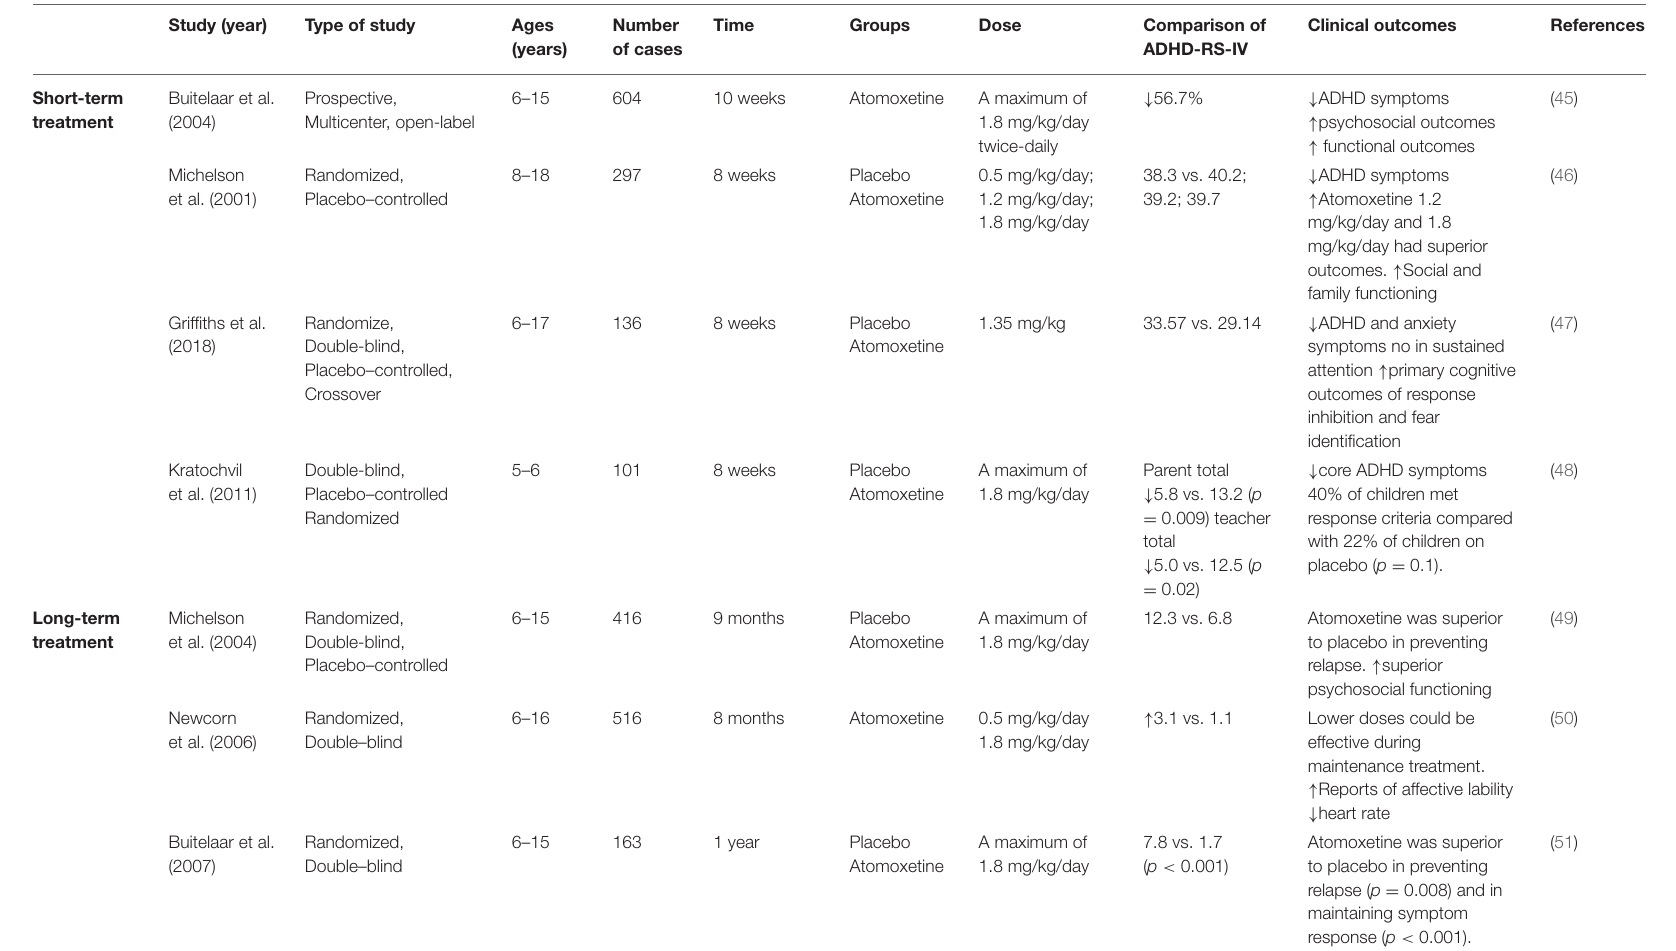
TABLE 1 | Summary of efficacy trials in atomoxetine treatment